Question: What visual encoding does this figure use to show its data?
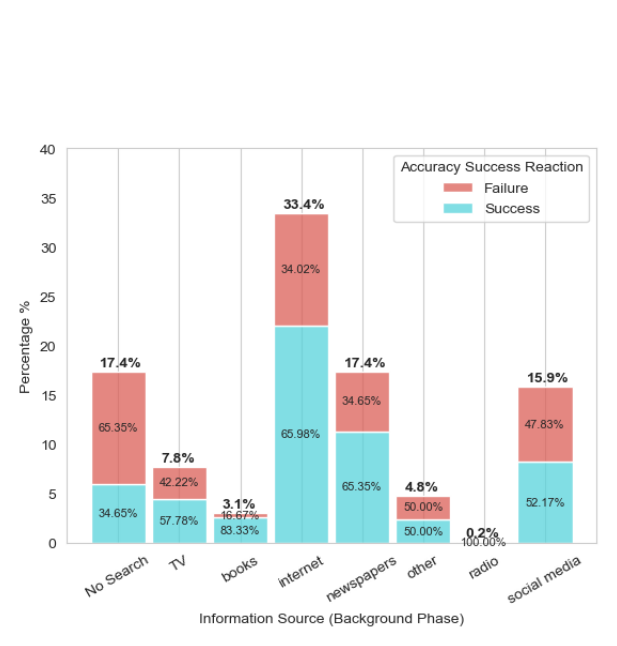
Answer: bar